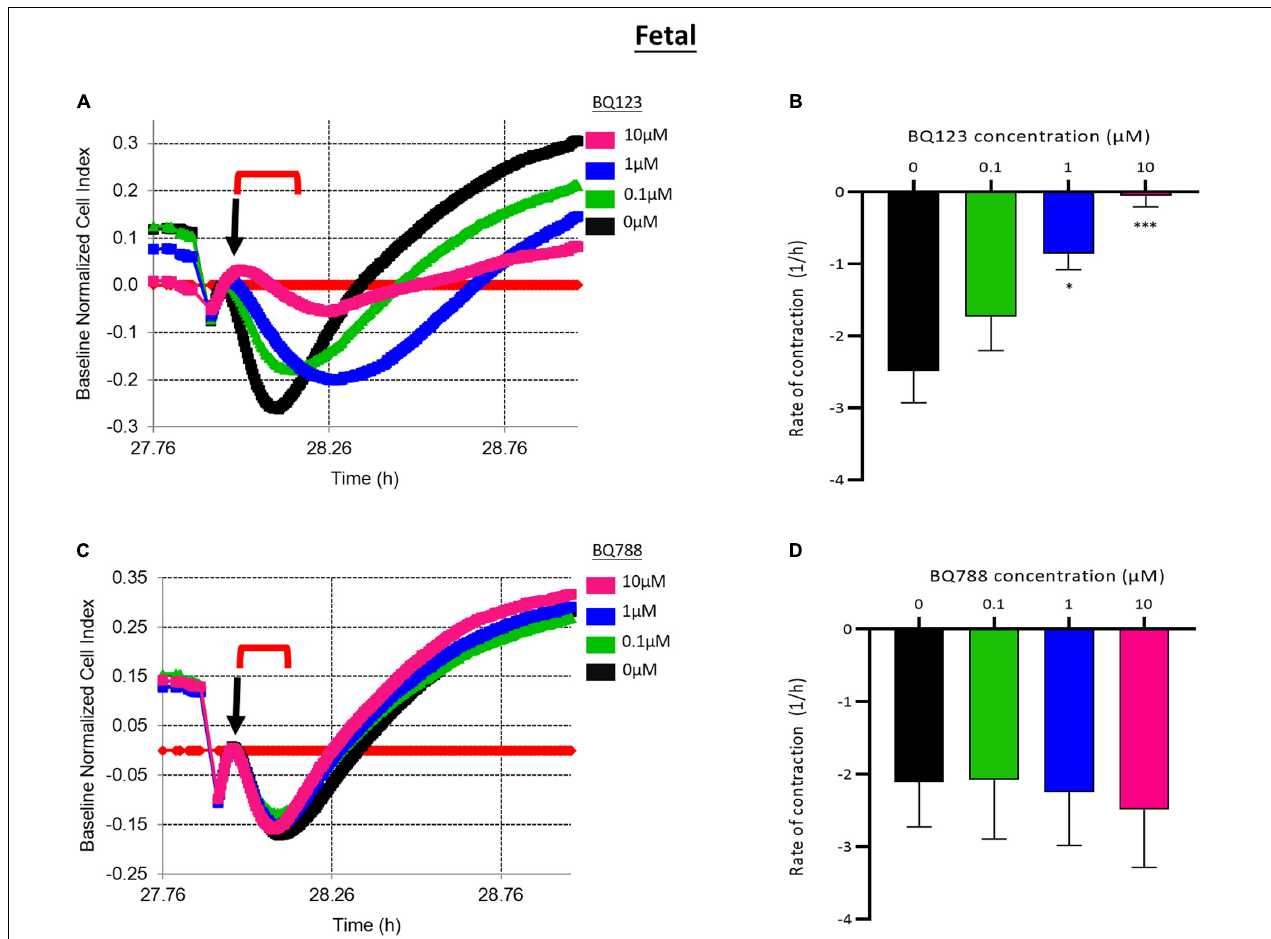
FIGURE 3 | (A) Representative electrical impedance measurements of the contractile response of fetal human brain vascular pericytes (fHBVP) to EDN1 in the presence of BQ123, an EDNRA antagonist. (B) The rate of contraction was significantly reduced in cells to which 1 µ M ( p = 0.0158) or 10 µ M ( p = 0.0001) BQ123 had been added ( n = 7). (C) Representative electrical impedance measurements of the contractile response of fHBVP in the presence of BQ788, an EDNRB antagonist. (D) There was no significant difference in the rate of contraction between BQ788-treated and untreated cells ( n = 7). The timeframe referred to in each graph is indicated by the red bracket. Arrows indicate the timepoint of EDN1 addition. The bars represent the mean values and